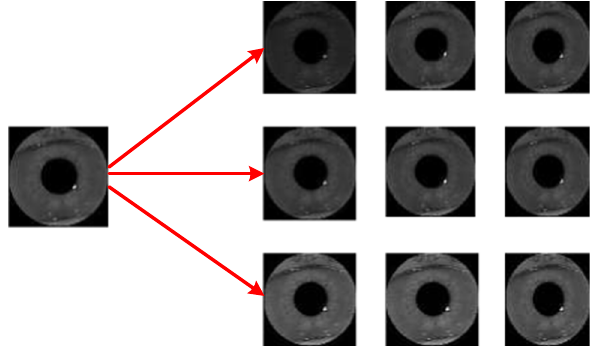
Fig. 6 One iris is augmented to nine